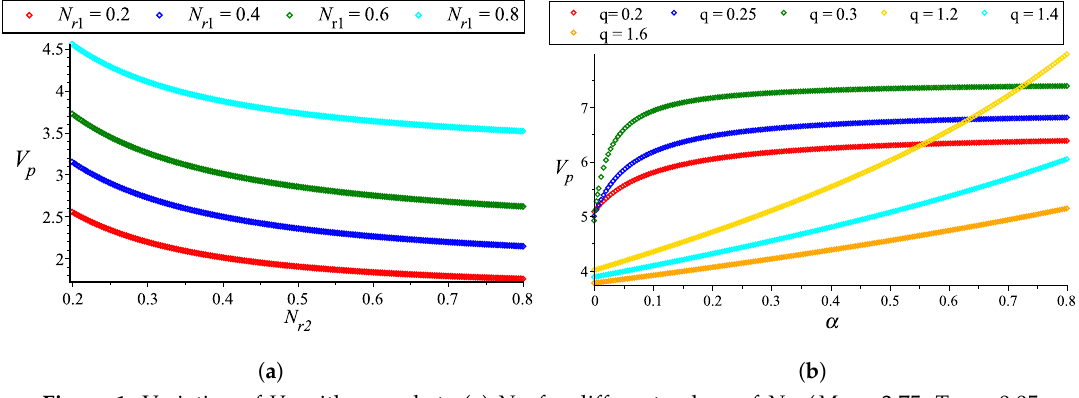
Figure 1. Variation of V p with regards to ( a ) N r 2 for different values of N r 1 ( M r = 3.75, T ni = 0.05, T e = 0.2, α = 0.5, and q = 1.6), and ( b ) α for different values of q ( M r = 3.75, T ni = 0.05, T e = 0.2, N r 1 = 0.5, and N r 2 = 0.1),